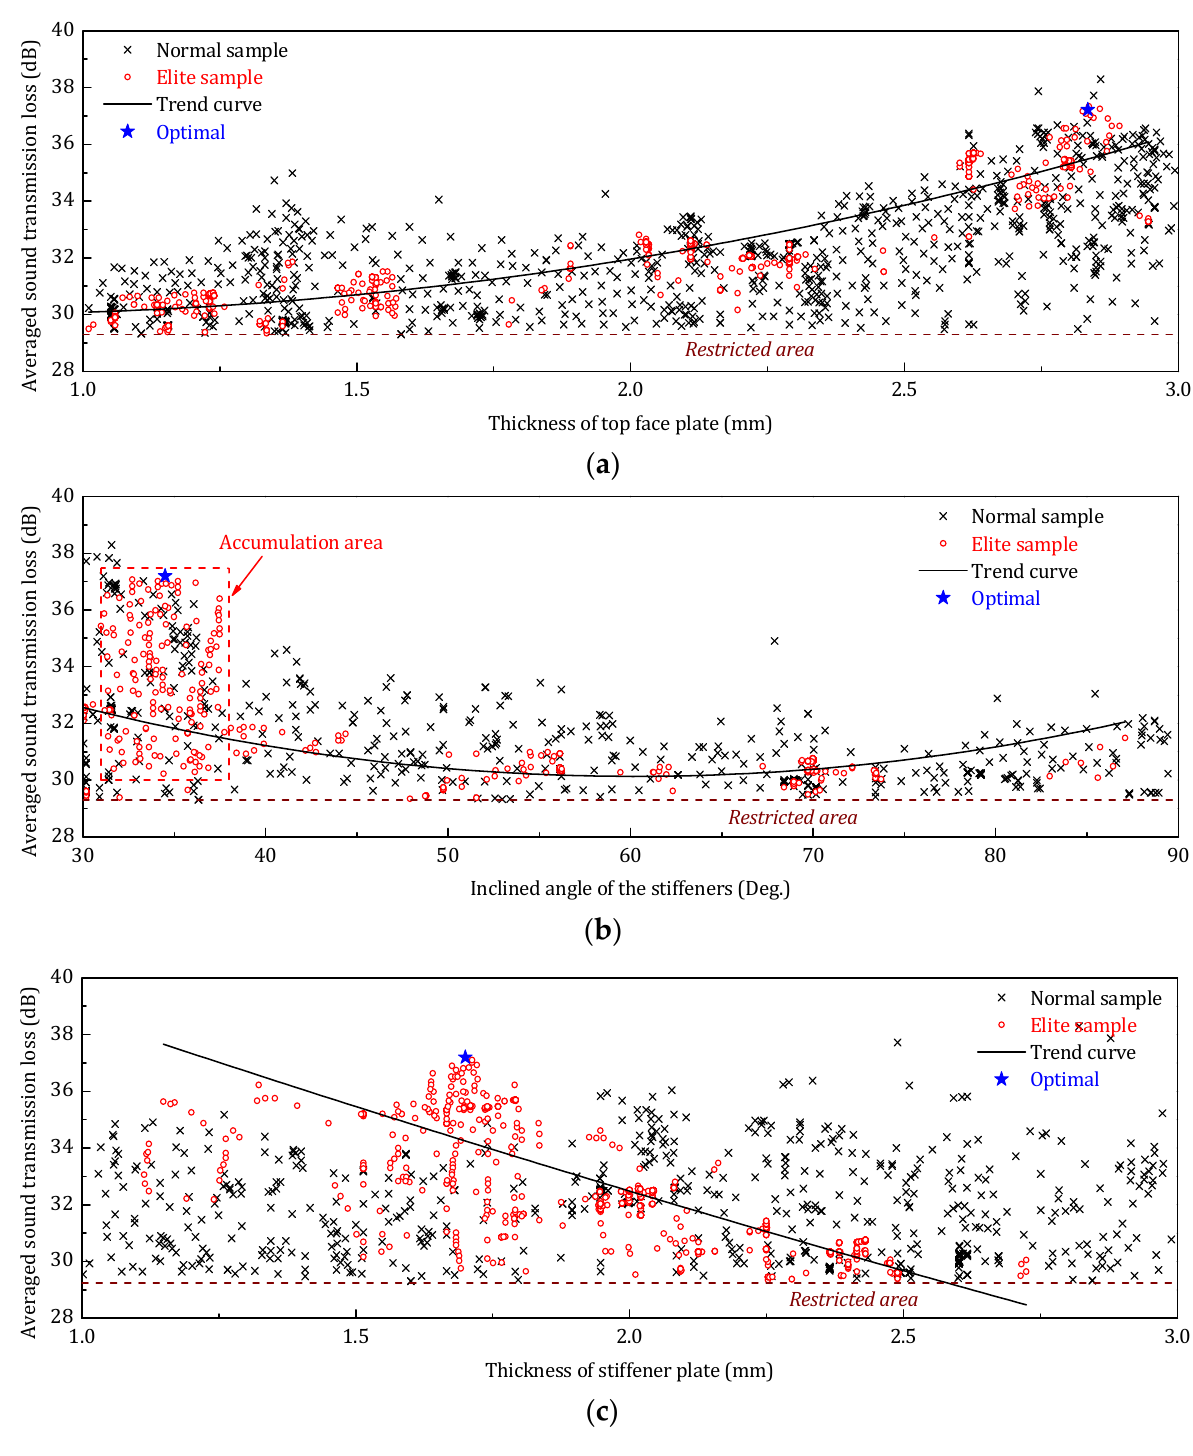
Figure 24. Optimization samples distribution of three design parameters (middle-frequency range). ( a ) Optimization samples distribution of h t ; ( b ) Optimization samples distribution of φ ; ( c ) Optimization samples distribution of h s .